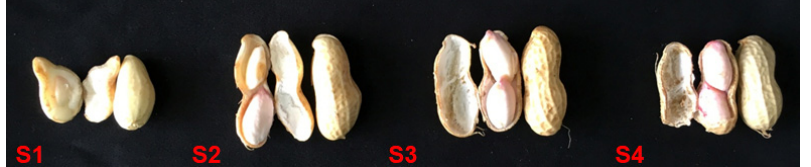
Figure 1. Four different developmental stages of peanut pods. S1: white and thick skin stage; S2: white and thin skin stage; S3: brown and thin skin stage; S4: black and thin skin stage.